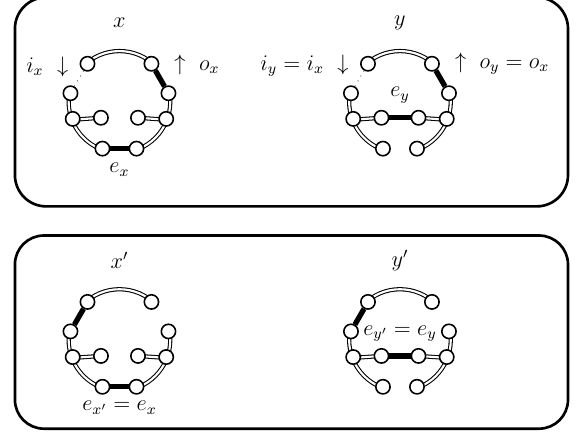
C e . Figure 8. Case 4. a .ii, case 4. b .ii, and case 4. c .ii, when o x / ∈ C e ∈